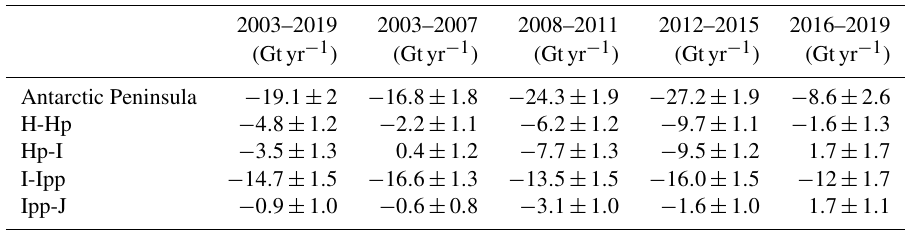
Table 2. Mean mass trends for the 2003–2019 period of the study and over various epochs for the AP region and individual basins (see Fig. 1 for drainage basin and region definitions; Rignot et al., 2011a, 2013) All uncertainty states as 1 σ .